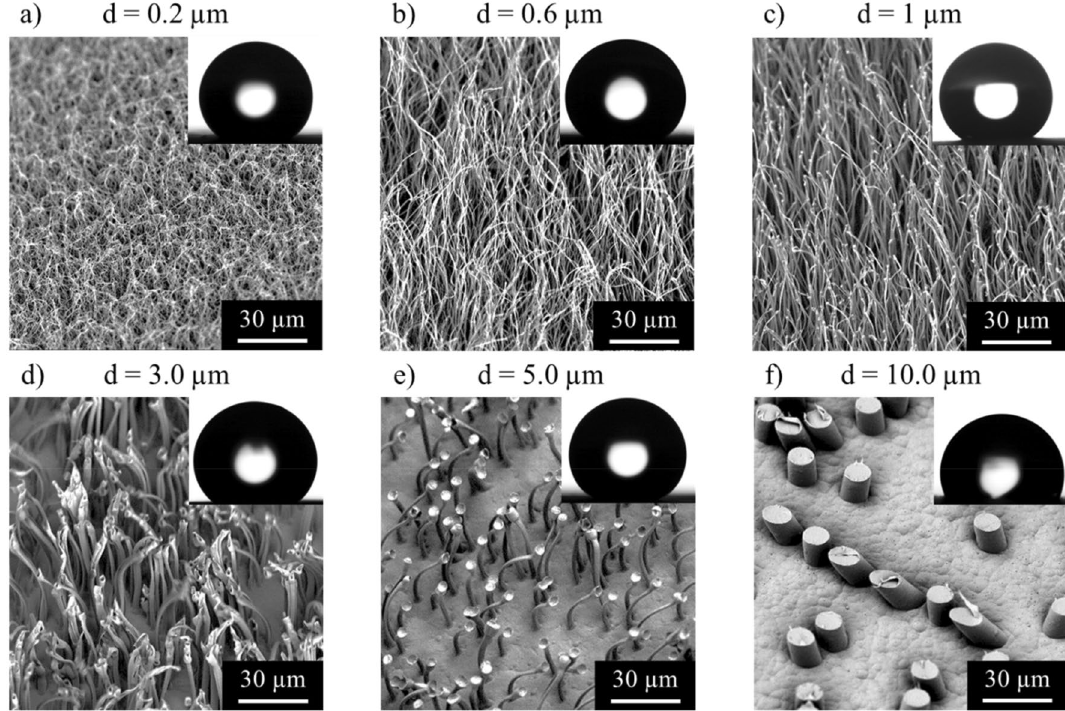
Figure 2. Scanning electron micrographs corresponding to various HDPE nano- and microstructures obtained by using PC membranes with pore diameter ranging from 0.2 µm to 10.0 µm. All samples were obtained under identical fabrication parameters (600 s seconds at 170 °C). The structures ( a–d ) show superhydrophobic behavior ( θ = 160° ± 10°; θ roll-off < 10°).